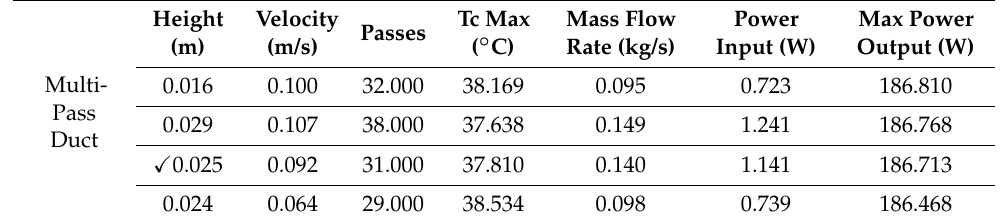
Table 4. Designed parameters of multi-pass duct type heat absorber. (cid:88) —specify the optimized absorber parameters for